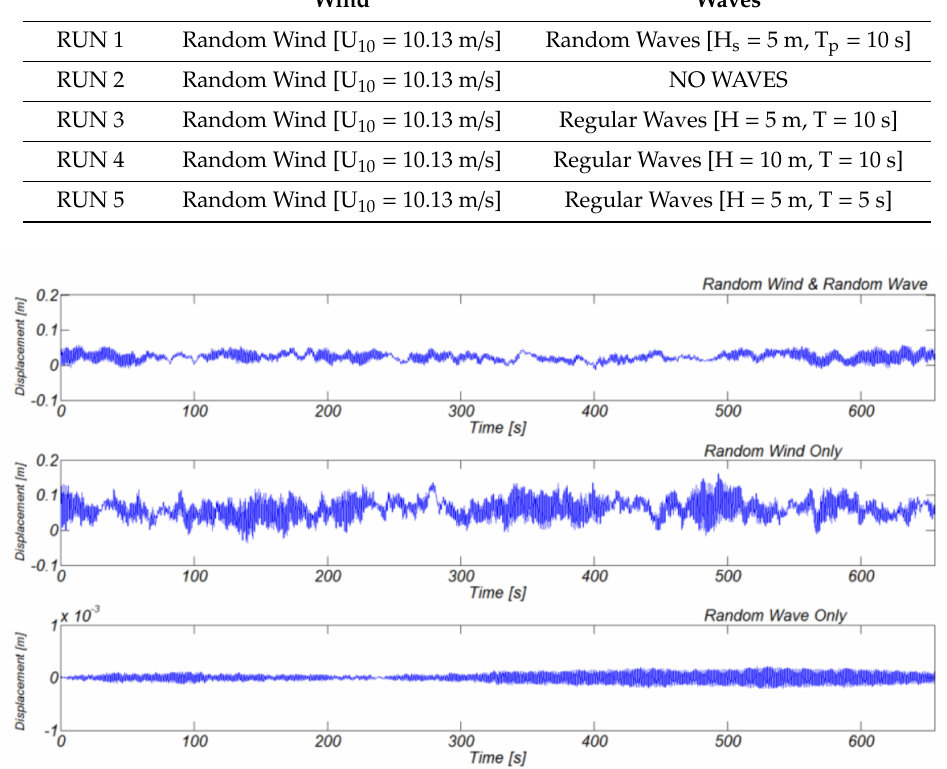
Figure 16. Numerically simulated response of the o ff shore wind turbine substructure against di ff erent combinations of external forces.